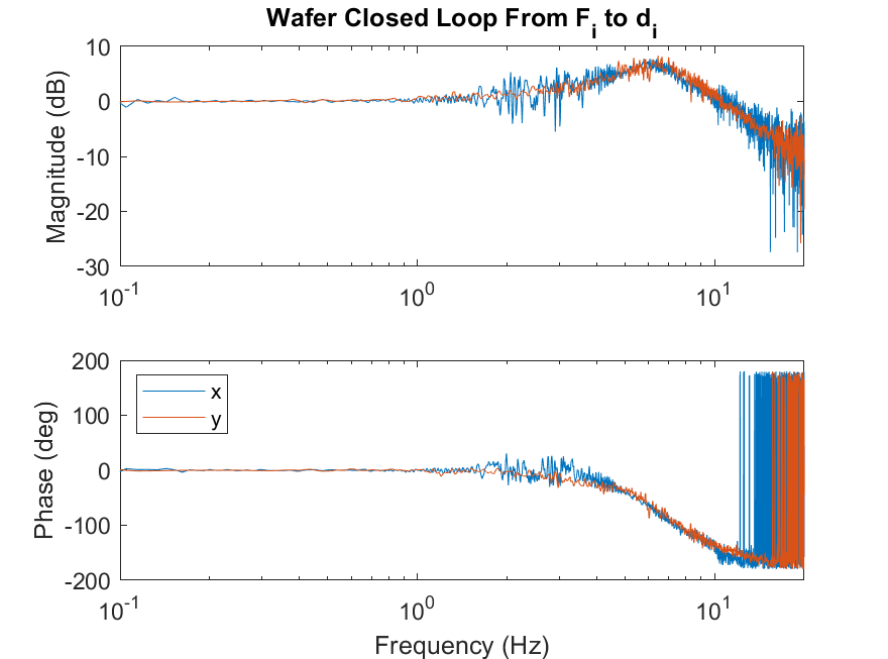
Figure 25. The closed loop frequency response of the Flowerbed—T from the reference position to the measured position for the